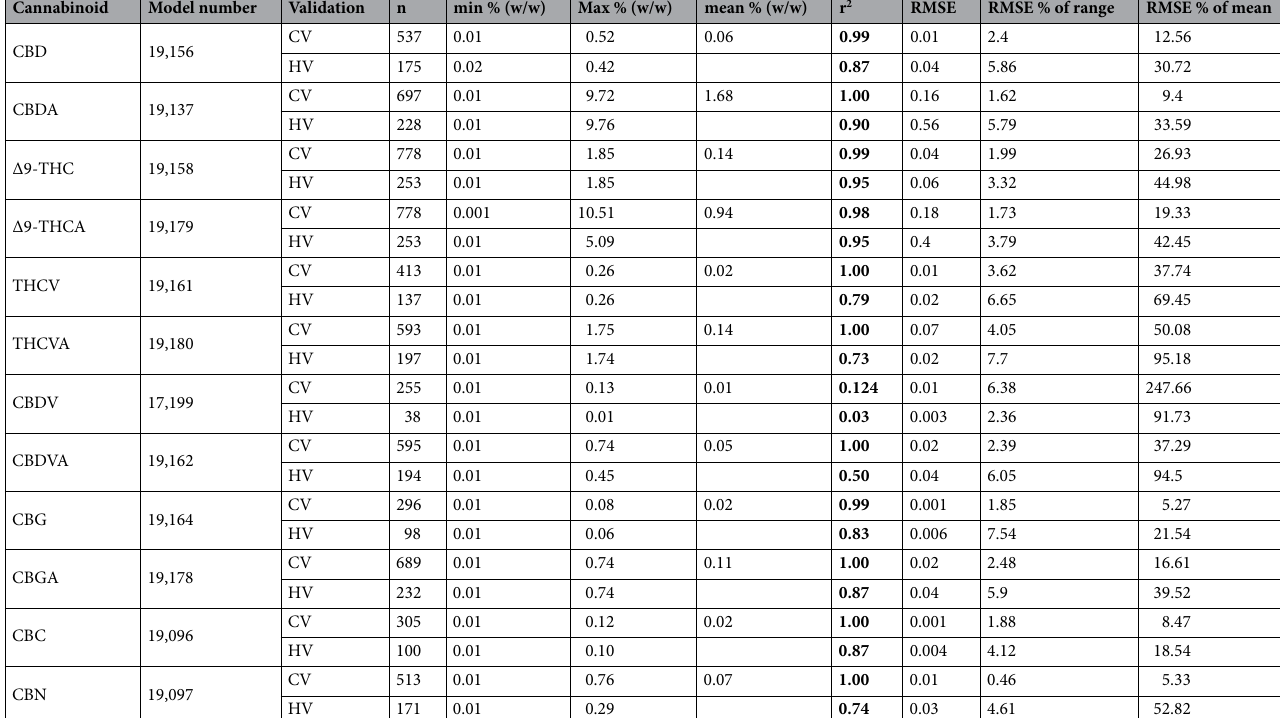
Table 1. Summary statistics for the best chemometric evaluation models. Cross-validation (CV) at 75% of sample size, hold-out validation (HV) at 25% of sample size, number of samples (n) used to build or validate the model. “CV” is cross validation, “HV” is hold out validation, “n” is sample number, “min” is the minimum cannabinoid concentration, and “max” is the maximum cannabinoid concentration in percent of cannabinoid weight by sample dry weight (% (w/w)), “r 2 ” is the regression coefficient, “RMSE” is the root mean square error. Significant values are in